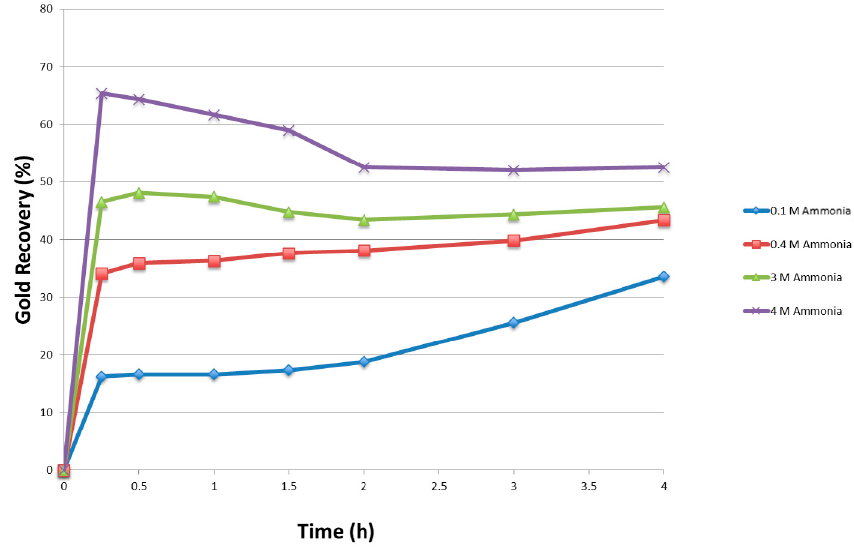
Figure 2. The influence of NH 3 concentration on gold recovery (2 M Na 2 S 2 O 3 ; 0.1 M CuSO 4 ).